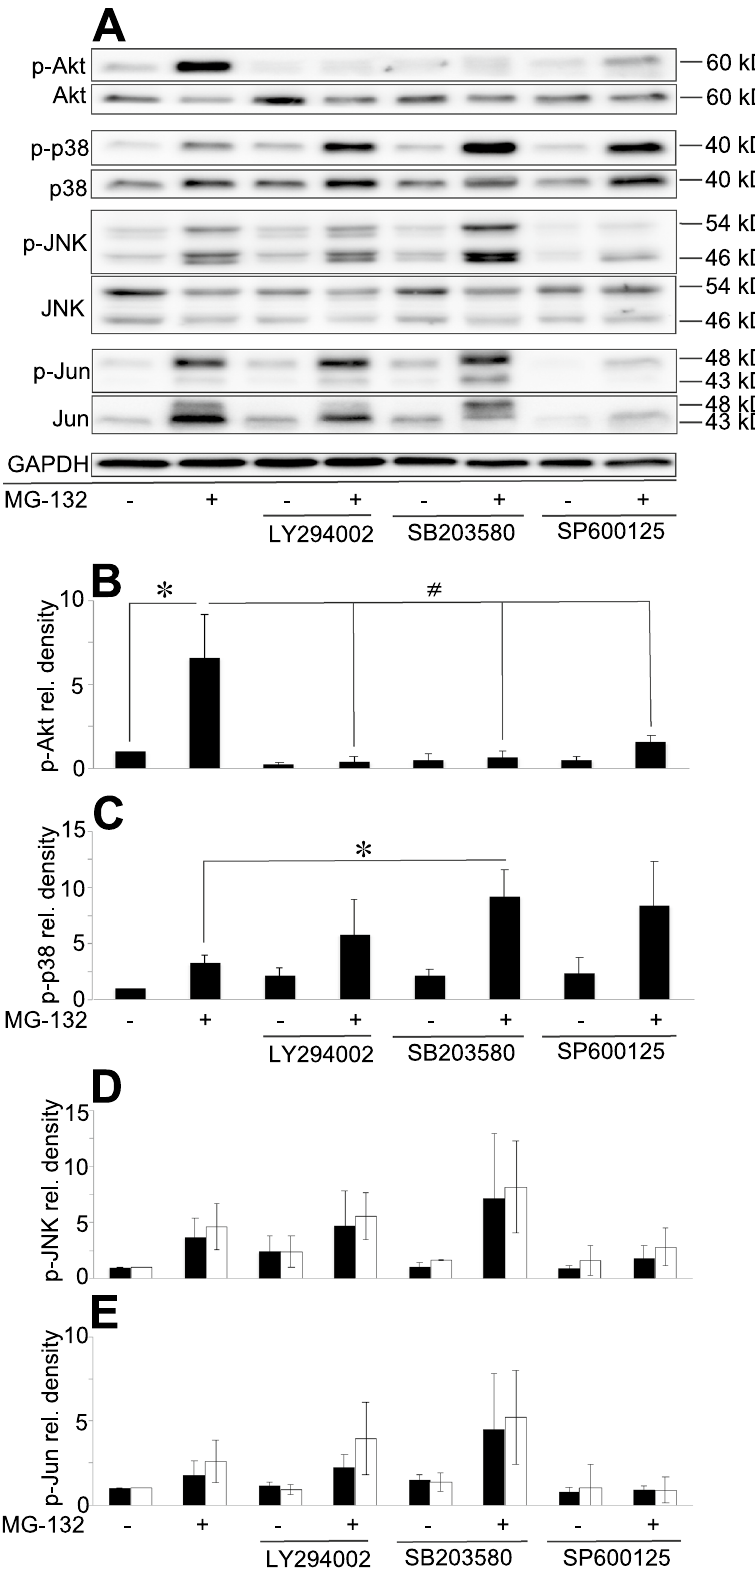
Figure 4. MG-132-induced phosphorylation of various signaling proteins using kinase-inhibitors. ( A ) Immunoblot analysis of Akt, p38, JNK and c-Jun phosphorylation in the presence of the PI3K inhibitor (LY294002) (20 µM), p38 inhibitor (SB203580) (10 µM) or JNK inhibitor (SP600125) (50 µM) in PC12 cells. Cultures were left untreated or were treated for 3 h with MG-132 (2.5 µM) and the inhibitors were added 1 h prior to the proteasome inhibitor treatment and remained present in the cultures until the end of the experiment (altogether 4 h). All blots were cropped, original membrane images are shown in Supplementary Fig. 4. Diagrams show the activation pattern of Akt ( B ), p38 ( C ), JNK ( D ) and c-Jun ( E ). Bars demonstrate the mean ratio ± SD values calculated from the data of three independent experiments. Statistically significant differences are indicated ( */# P ≤